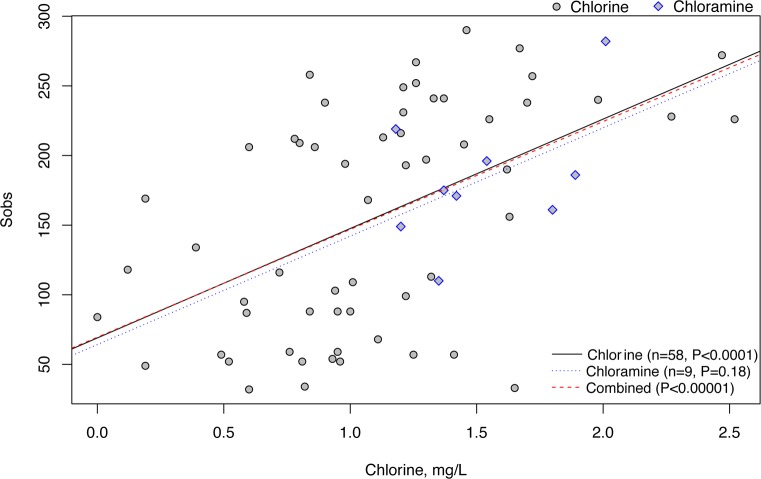
The relationship between OTU richness and total chlorine concentration.Samples from DWDSs treated with chlorine (gray circles) and chloramine (blue diamonds) were analyzed separately. Best-fit lines for each disinfectant type and for the entire dataset are shown with their respective P-values.